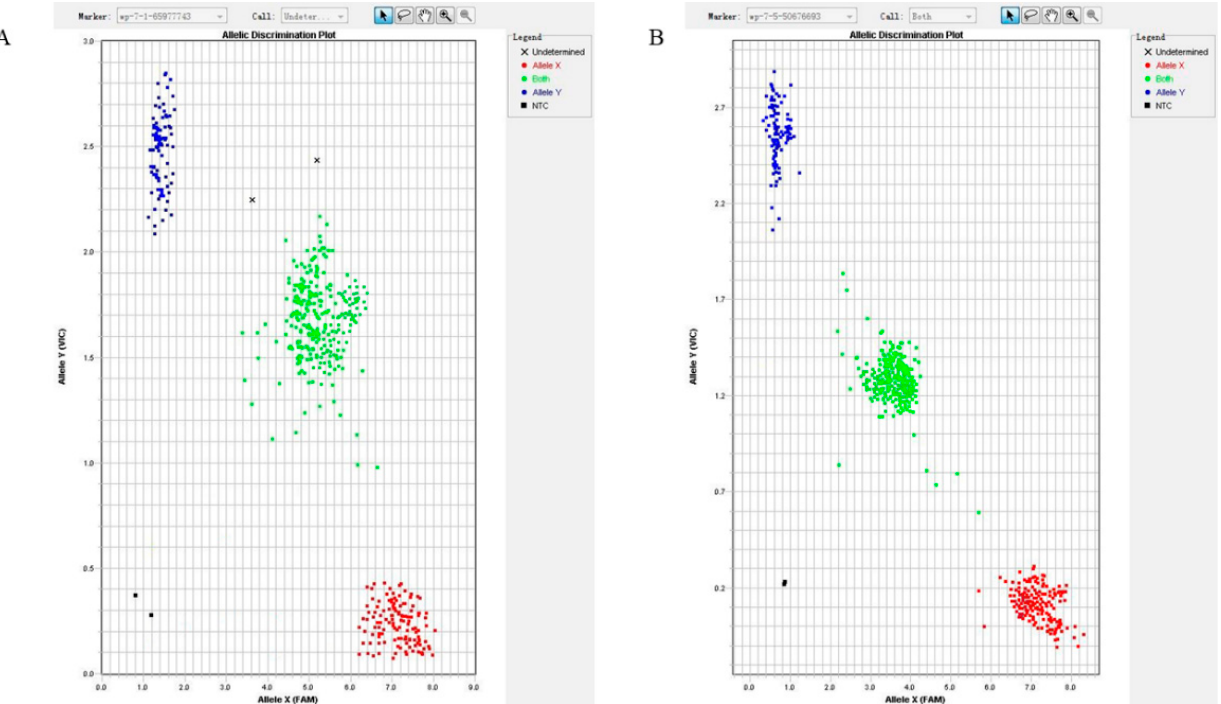
Figure 1. Genotyping of SNPs by KASP method. ( A ) PPP2R5C g.65977743C>T; and ( B ) SLC39A5 g.50676693T>C. Note: blue color dots, green color dots and red color dots represent the individuals with TT , TC and CC genotype, respectively.